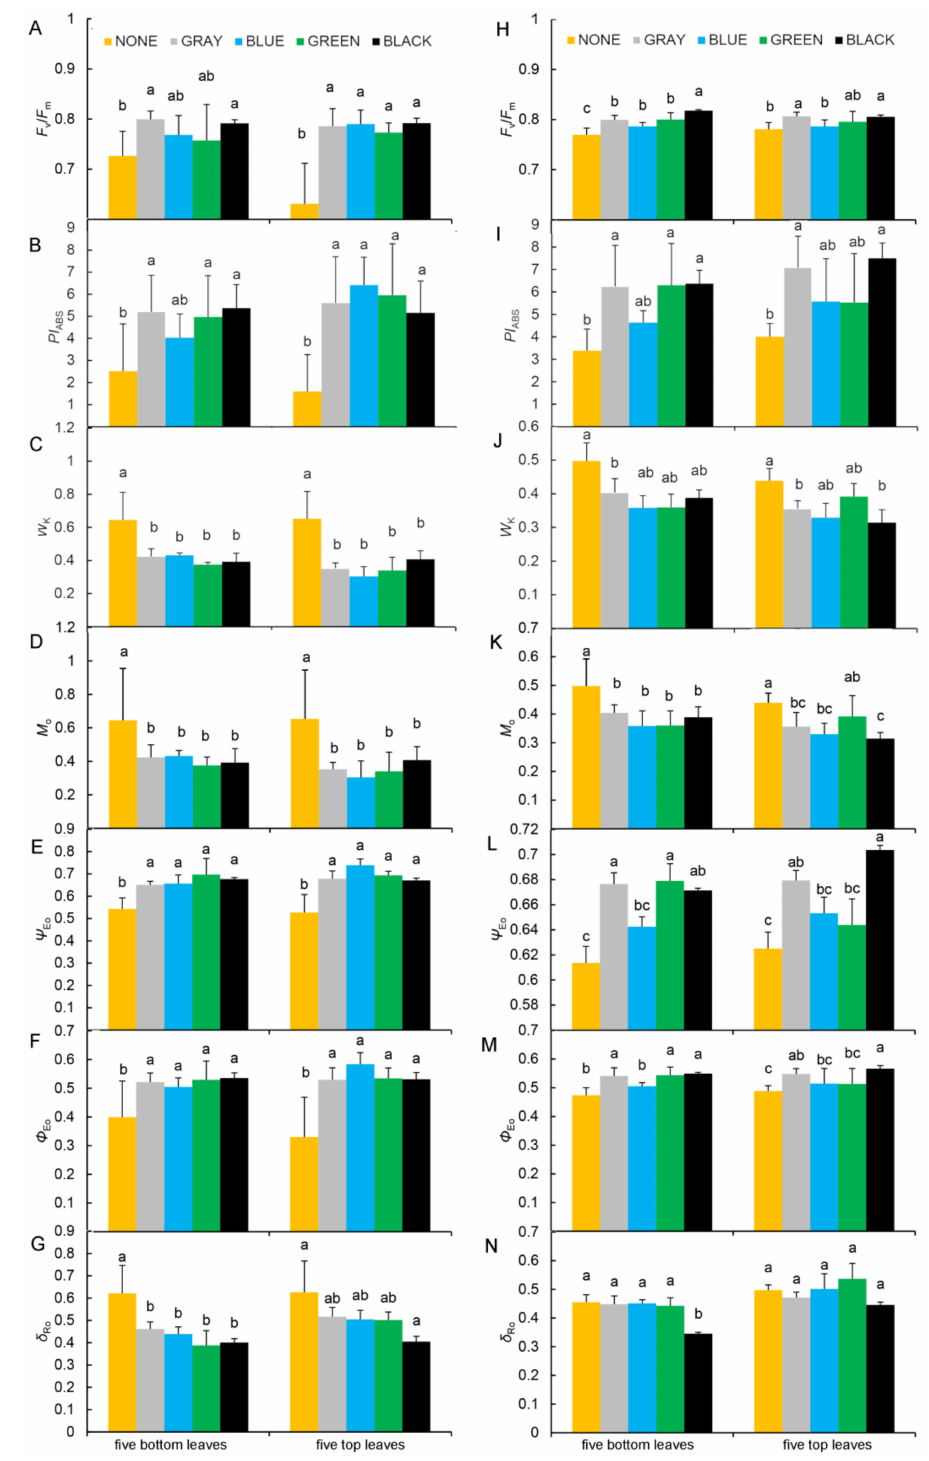
Figure 5. Differences in PSII-related parameters of grapevine leaves under the different treatments. F v / F m , PI ABS , W k , M o , Ψ Eo , Φ Eo , and δ Ro at PQ ( A – G ) and ZH ( H – N ). NONE, no shading; GRAY, BLUE, GREEN, and BLACK, shade net colors. Different lowercase letters indicate significant differ- ences ( p <